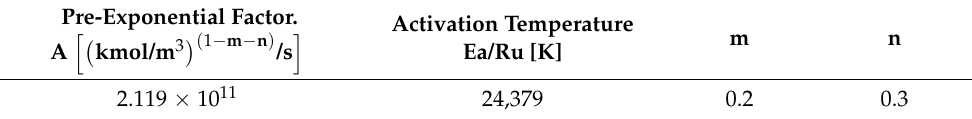
Table A4. Parameters of the chemistry model for the methane and air reaction. Pre-Exponential